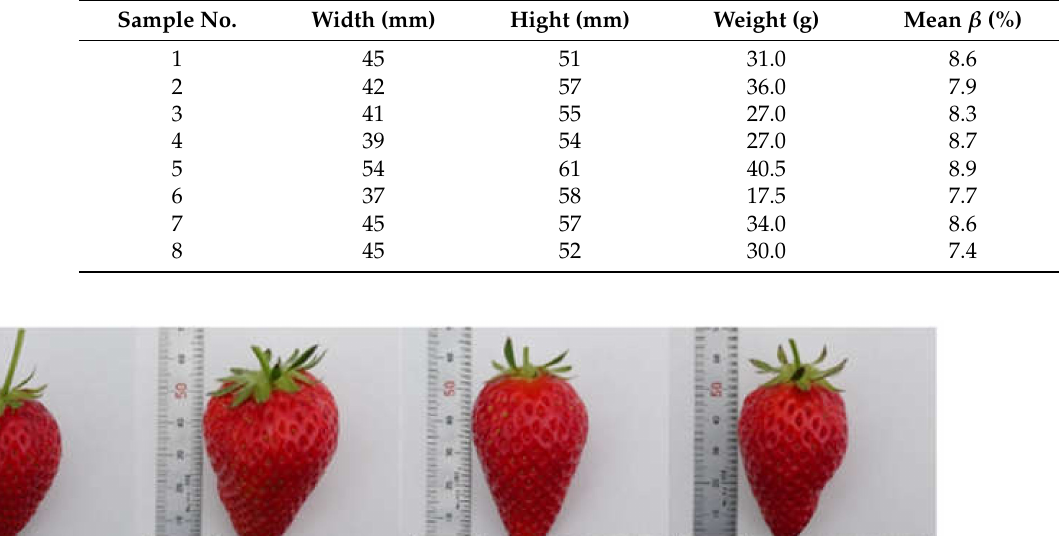
Table 4. Strawberry quality parameters on 5 April 2021.